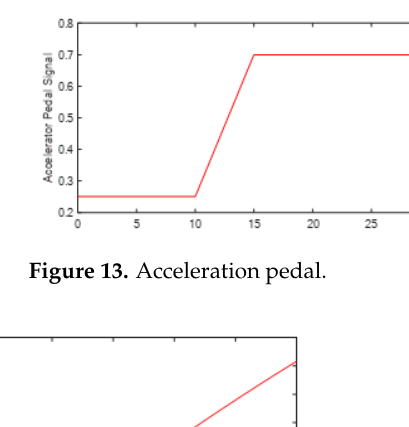
Figure 12. Large steering wheel angle.